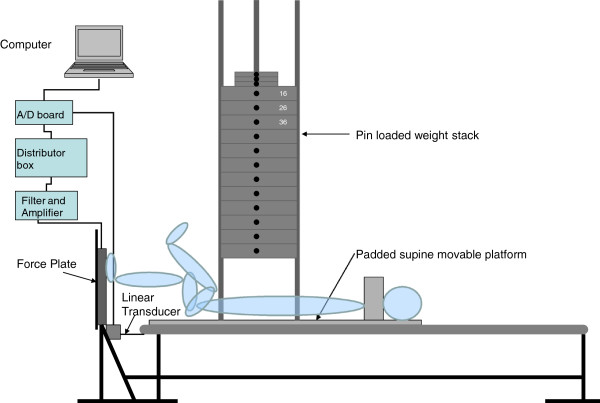
 Schematic representing the modified leg press machine and the position of the participants at the start of testing. The tested limb is at 90 degrees of hip and knee flexion.